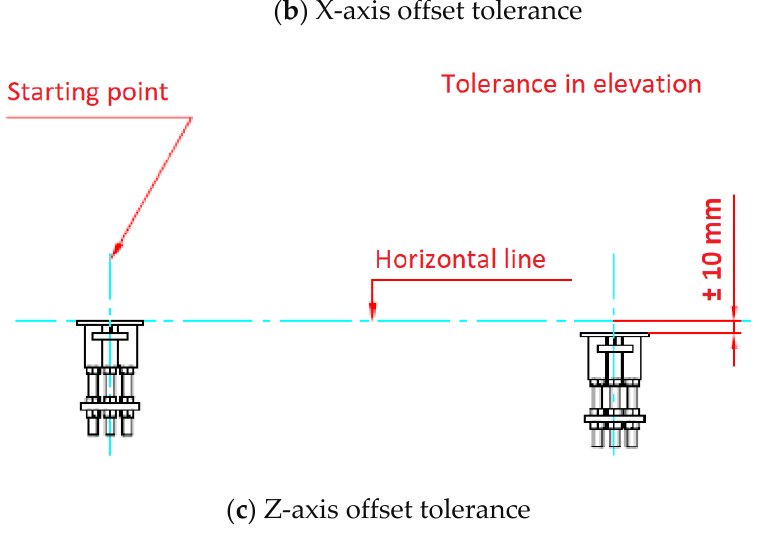
Figure 16. Design tolerance.